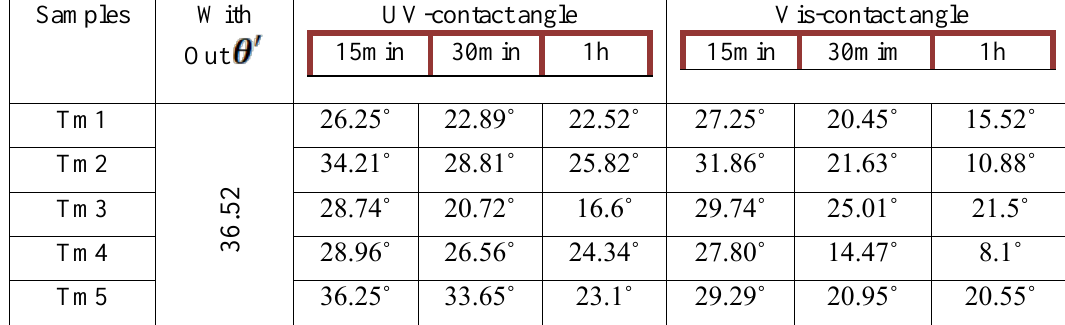
(Tm5): a-15min Vis irradiation, 2 all 2